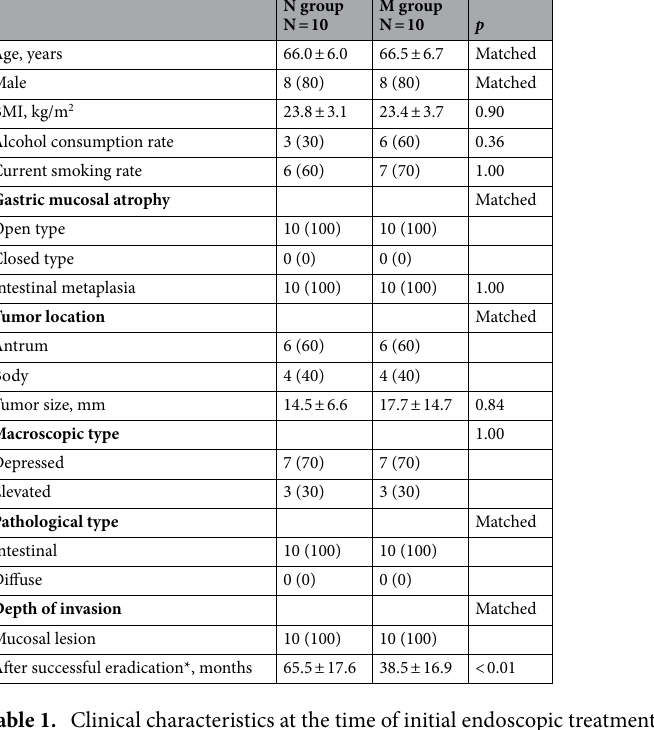
Table 1. Clinical characteristics at the time of initial endoscopic treatment. Values are expressed as means ± standard deviations or as n (%). *We selected the patients in the M group > 1 year after they had undergone curative resection and successful HP eradication; we selected the patients in the N group > 3 years after they had undergone ESD and successful HP